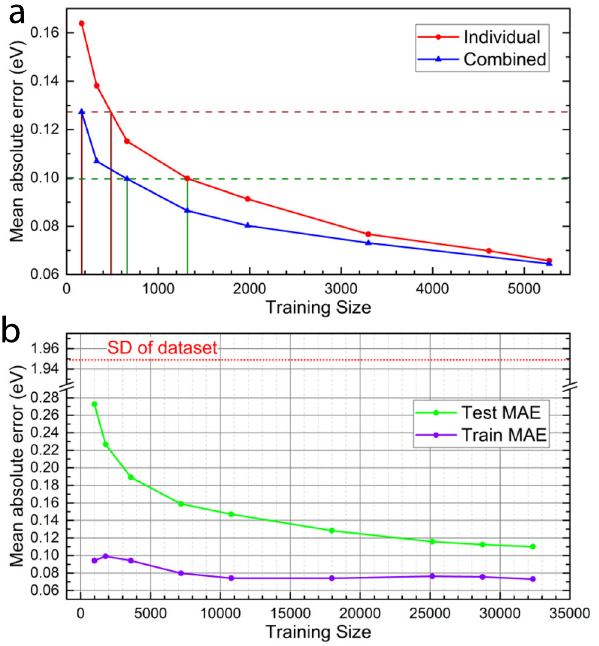
Fig. 4 Training size dependence of DOSnet performance. a Mean absolute error versus training size for DOSnet on the hydrogen adsorbate. A comparison is made between DOSnet trained individually on H (red) and DOSnet trained while including all other adsorbates in the combined approach (blue). Colored guide lines highlight the reduced training data needed in the combined case which takes advantage of transfer learning. b Mean absolute error of the test set and train set versus training size for the combined DOSnet approach trained on all